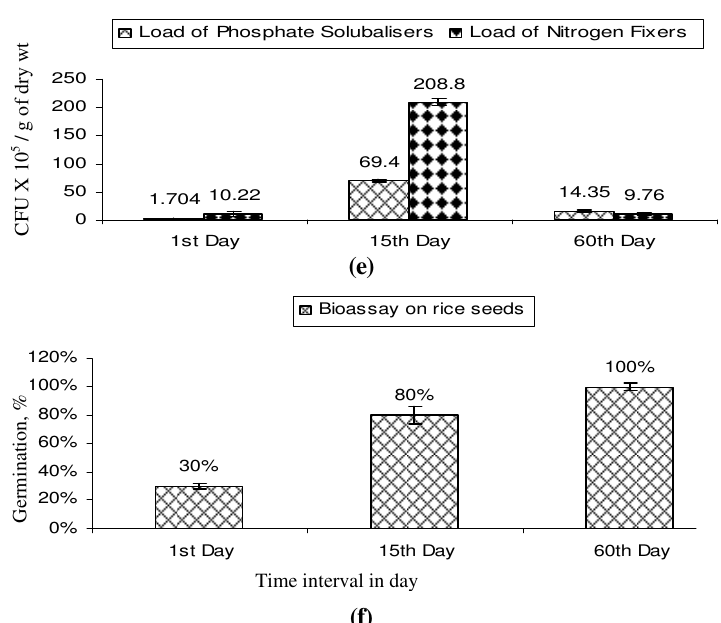
Figure 2(a). Physicochemical analysis of temperature (°C), pH, Moisture content (%) and Electrical conductivity (mS). ( b ) Humic acid and ammonical nitrogen content during composting. ( c ) Phenolic content during composting. ( d ) Biochemical indices of enzyme amylase, invertase and urease. ( e ) Microbial ( Azatobacter and Rhizobium isolates) load during composting. ( f ) Bioassay on rice seeds germination during a time interval of 1 st , 15 th and 60 th day of